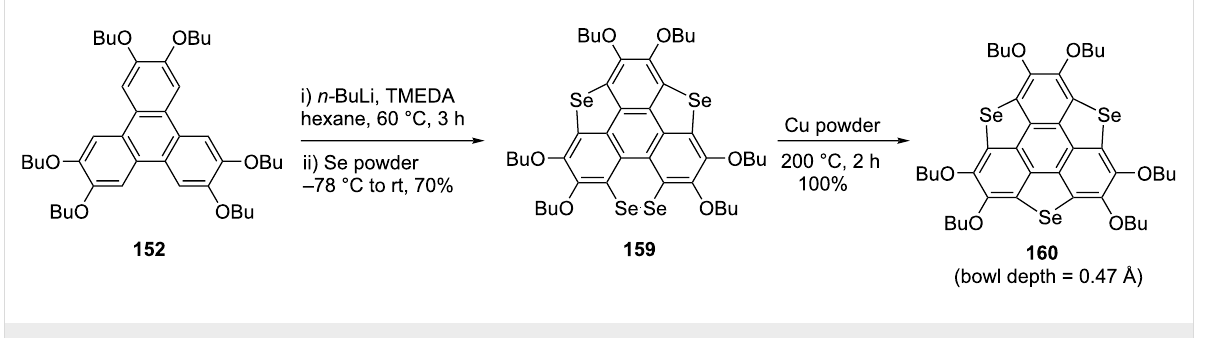
Scheme 42: Synthesis of triselenasumanene 160 by Shao and